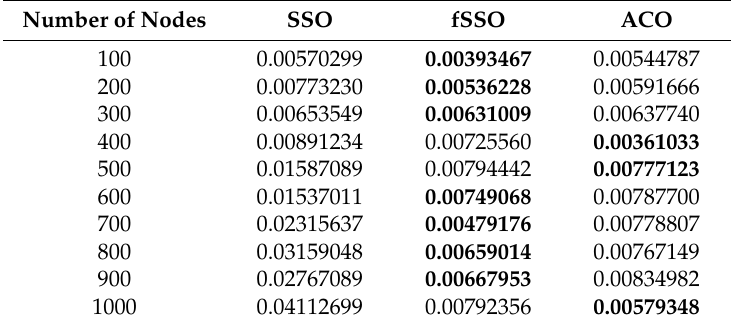
Table 19. Standard deviation of running time of fSSO compared with SSO and ACO for ten